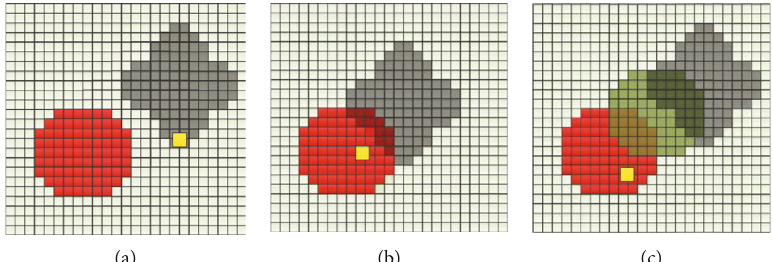
Figure 1: Relationships between objects in di ff erent positions: (a) nonoverlapping condition; (b) two overlapping objects detected as one; (c) three overlapping objects detected as one. Table 1: De fi nition of the image feature.